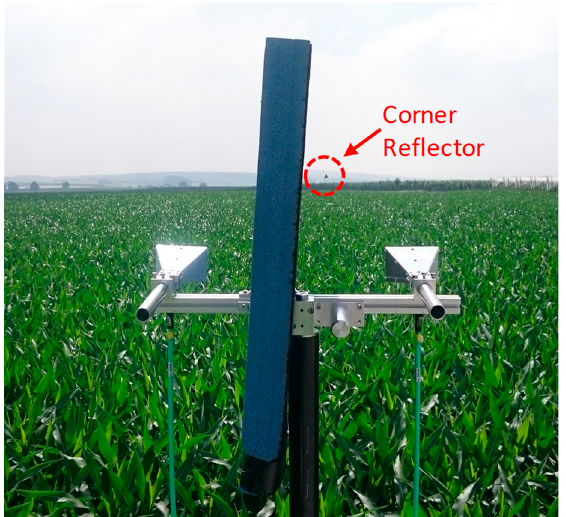
Figure 7. The two radar antennas were mounted on a tripod with variable heights. A plate of absorbing material was installed between the antennas for isolation purposes. This picture shows the propagation over sweetcorn along path A.